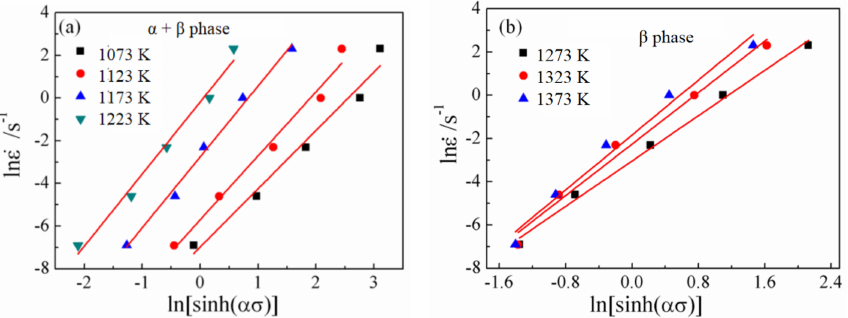
. ε at ( a ) the α + β phase region and ( b ) the β